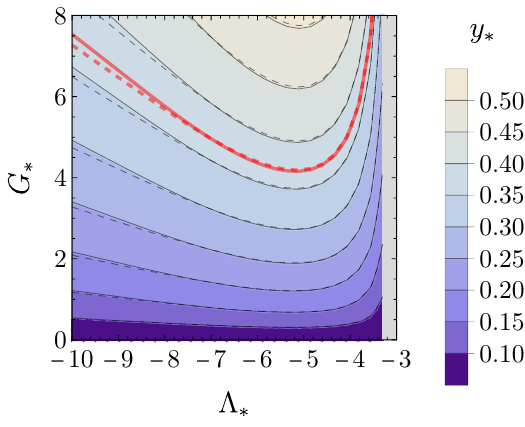
Figure 3 . We show contours of constant fixed-point value for the Yukawa coupling in the G ∗ − Λ ∗ - plane. Contours without a dark sector are shown in dashed, contours with the dark sector in continuous lines. The contours at y are shown in red lines.